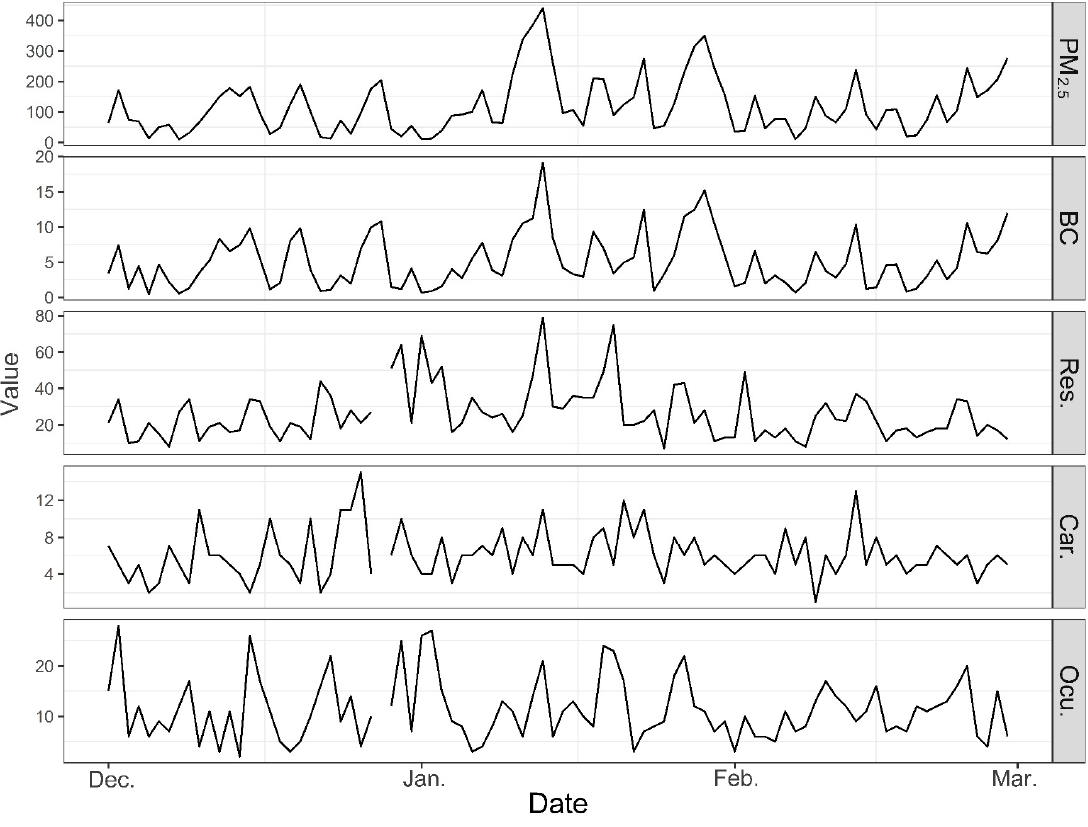
Figure 2. Time-series plot of daily PM 2.5 and BC concentrations and cause-specific hospital emergency room visits (ERVs) during the study